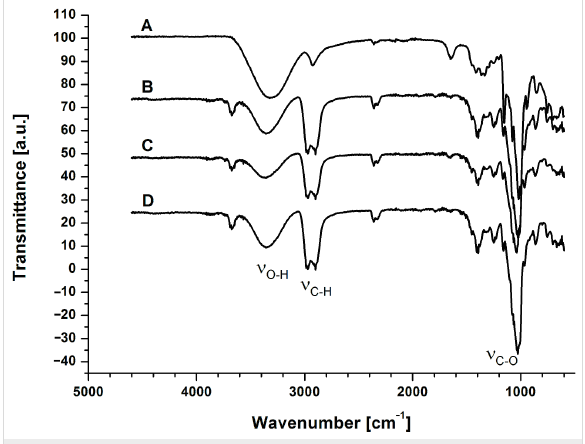
Figure 1: FTIR spectra of (A): native CRYSMEB, (B): D3 (toluene/CD 3:1), (C): D2 (toluene/CD 4:1), and (D): D1 (toluene/CD 1:4)